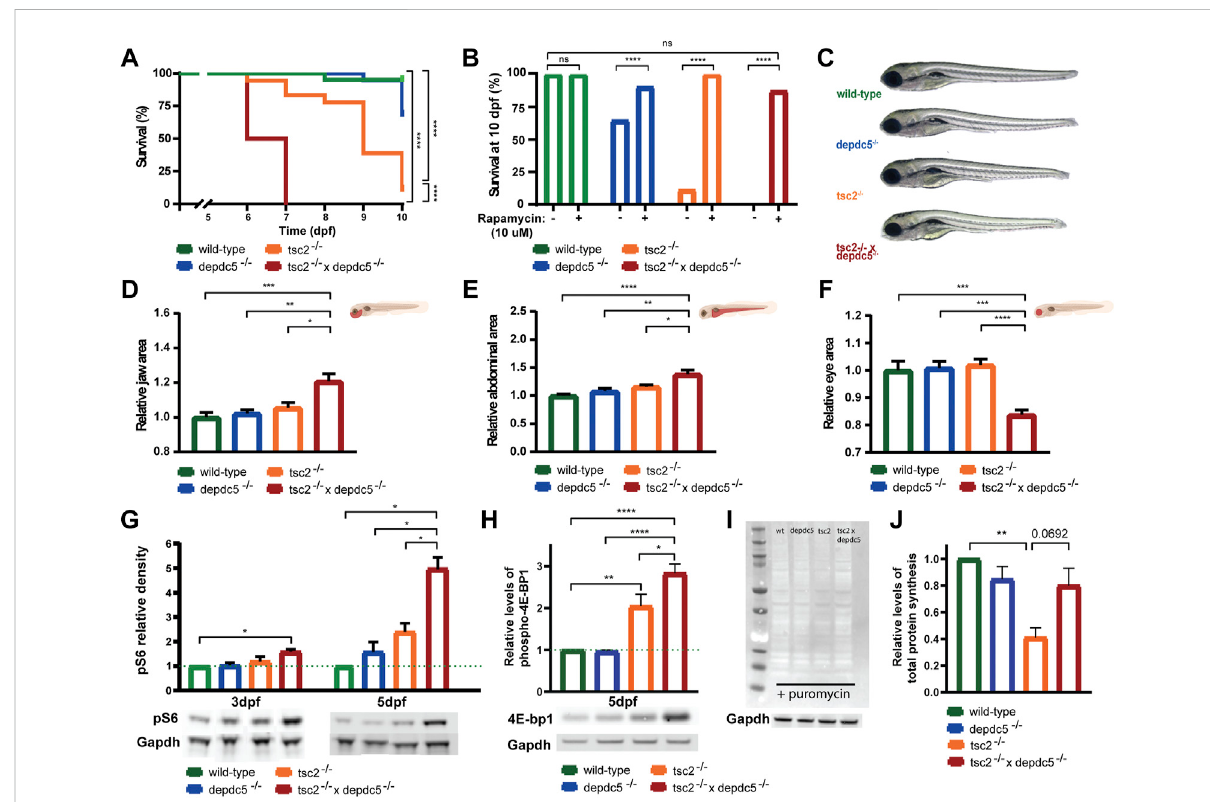
FIGURE 1 Survival analysis and morphological alterations in double homozygous larvae. (A) Kaplan-Meier curves of wild-type, depdc5 − / − , tsc2 − / − , and doublehomozygouslarvae.Viabilityoflarvaewasassesseddailyfrom0dpfuntil10dpf.Signi fi cantvalues(Logranktest)arenotedas**** p < 0.0001. (B) Survival proportions at 10 dpf of wild-type, depdc5 − / − , tsc2 − / − , and double homozygous larvae with or without 10 μ M rapamycin treatment. Signi fi cant values (one-way ANOVA) are noted as **** p < 0.0001. (C) Representative images of 5 dpf wild-type, depdc5 − / − , tsc2 − / − , and double homozygous larvae. (D) – (F) Quanti fi cation of jaw size (D) , abdominal area (E) and eye size (F) in (C). Data are presented as mean ± SEM, n